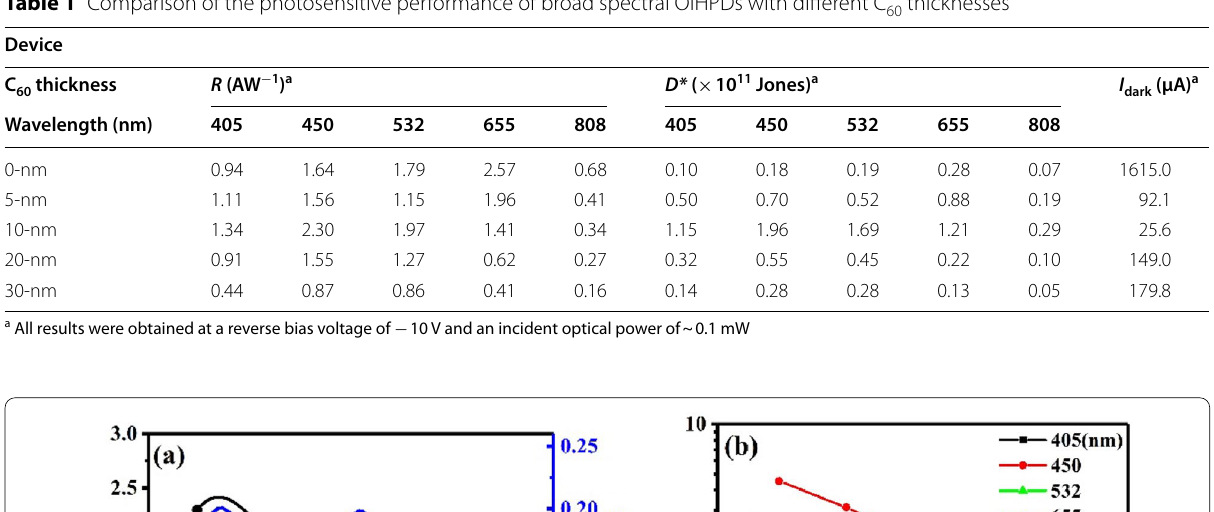
Table 1 Comparison of the photosensitive performance of broad spectral OIHPDs with different C